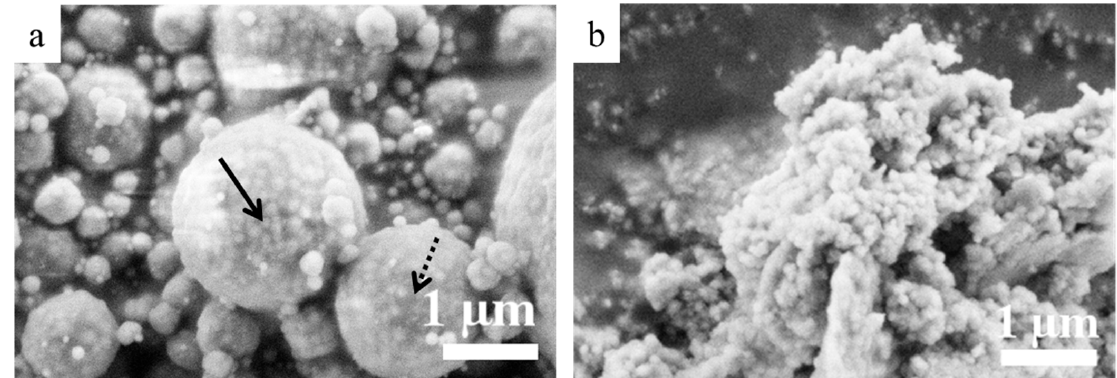
Figure 4. ( a ) SEM images of spray-dried nanosized zeolites showing spherical particles of nanocrys- tals (continuous arrow) dispersed in amorphous silica (broken arrow). ( b ) Solid phase collected after drying the suspension from hydrothermal synthesis of nanosized zeolites at 90 ◦ C. Both samples originated from the same suspension but were dried differently.